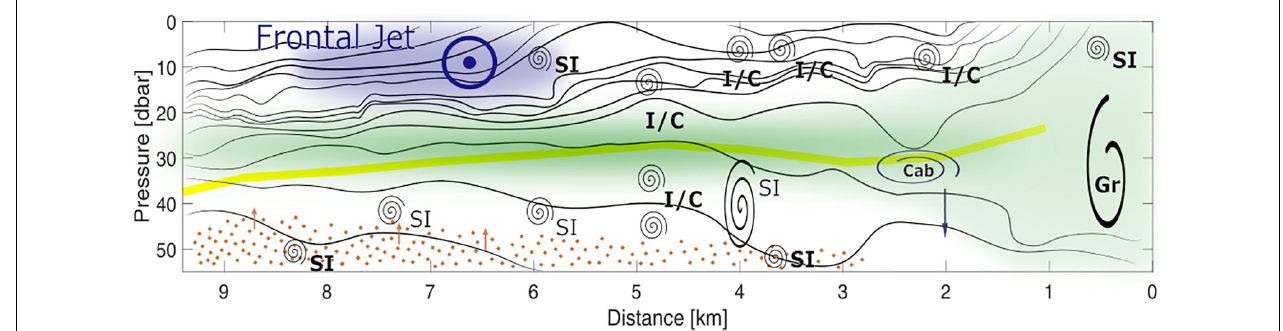
FIGURE 6 | Schematic illustrations of the major observed features and processes. Black lines – density contours, green patch – phytoplankton patch, yellow line – euphoric depth, blue patch – frontal jet coming out of the page, brown dots and arrows – nitrate and nitrate flux. The spirals indicate mixing in general while distinct mixing processes are indicated by text with Gr – gravitational instability, cab – cabbeling with the arrow indicating densification and sinking, I/C – inertial/centrifugal instabilities, and SI – symmetric instabilities. Bold text indicates where the required conditions were met while normal font indicates locations where the vorticity was close to zero which might be a sign of previously past symmetric